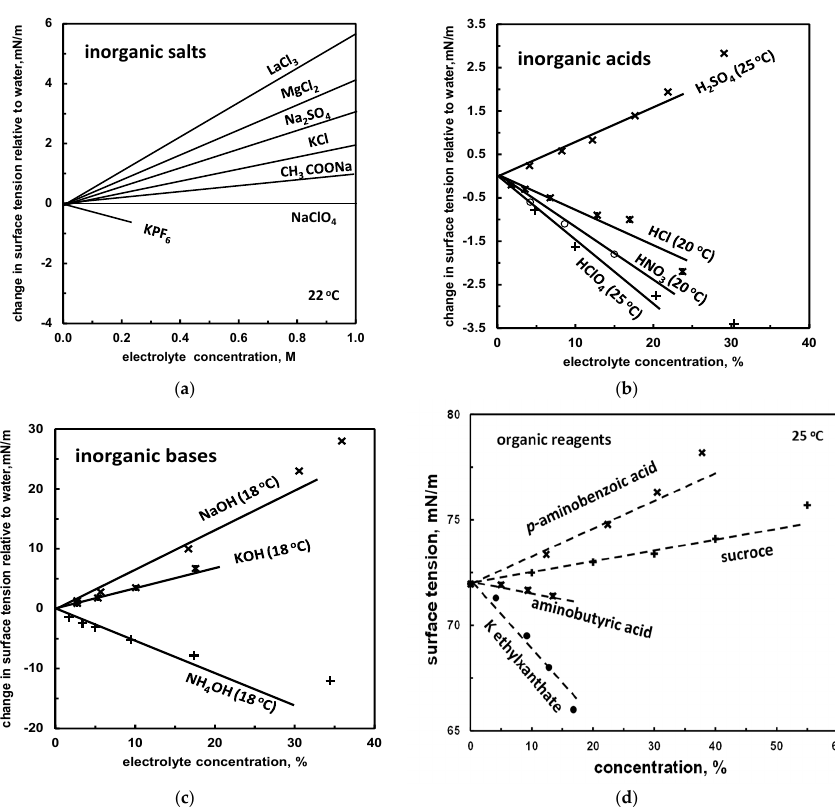
Figure 3. Slope of surface tension of aqueous solution of selected organic and inorganic reagents, ( a ) inorganic salts [32]; ( b ) inorganic acids [19]; ( c ) inorganic bases [19]; ( d ) organic reagents ([19,33], assumed solution density 1 g/cm 3 ). Table 9. σ ∠ values for selected surface active (non-surfactant)